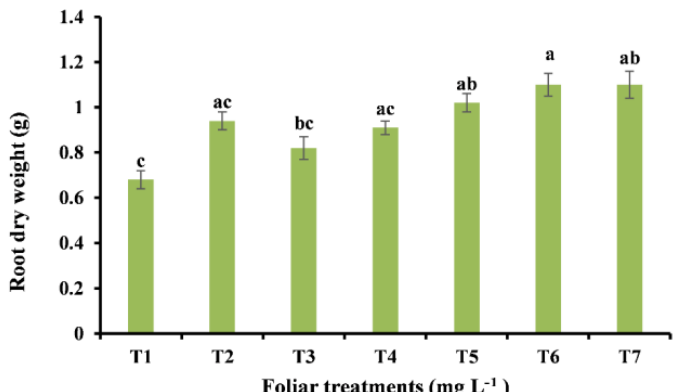
Figure 3. Effects of different foliar treatments on root dry weight of Aloe vera . Different letters on bars indicate significant differences among foliar treatments at p < 0.05 by LSD test. T1: control, T2: Magnetic Fe nanoparticle, T3: Zn nanoparticle, T4: KNO 3 , T5: Fe + Zn nanoparticles, T6: Fe nanopar- ticle+ KNO 3 , T7: Zn nanoparticle+ KNO 3 .